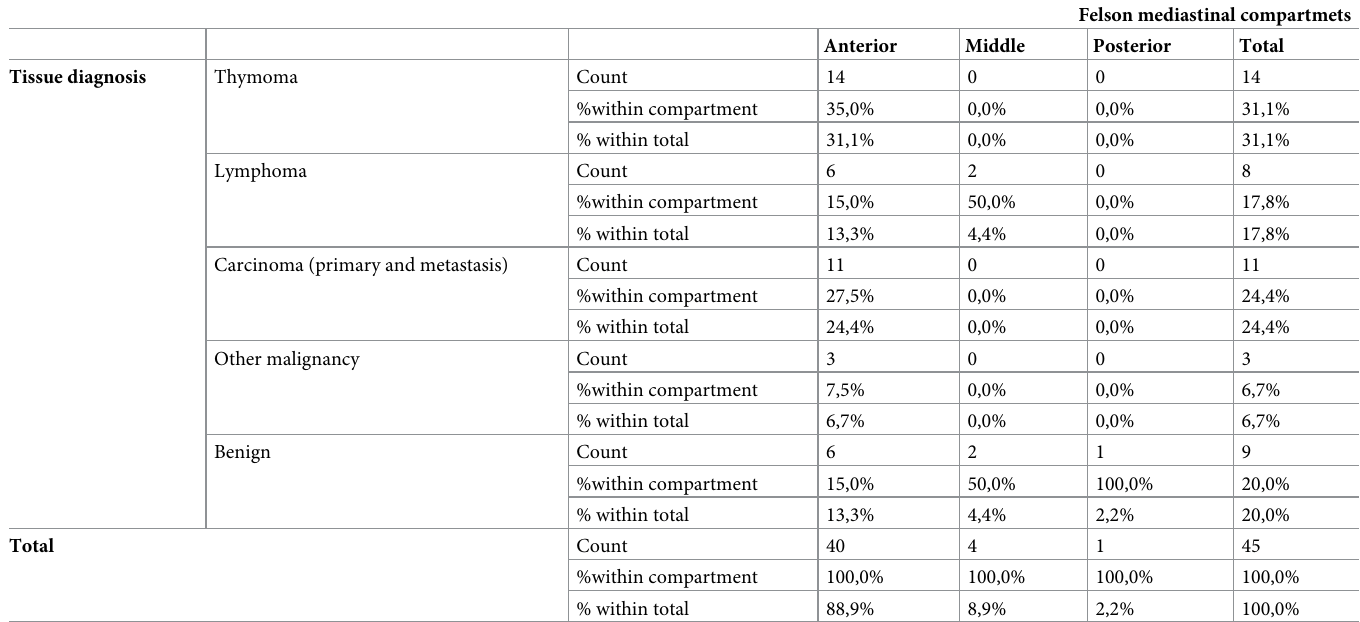
Table 5. Tissue diagnosis and Felson’s mediastinal